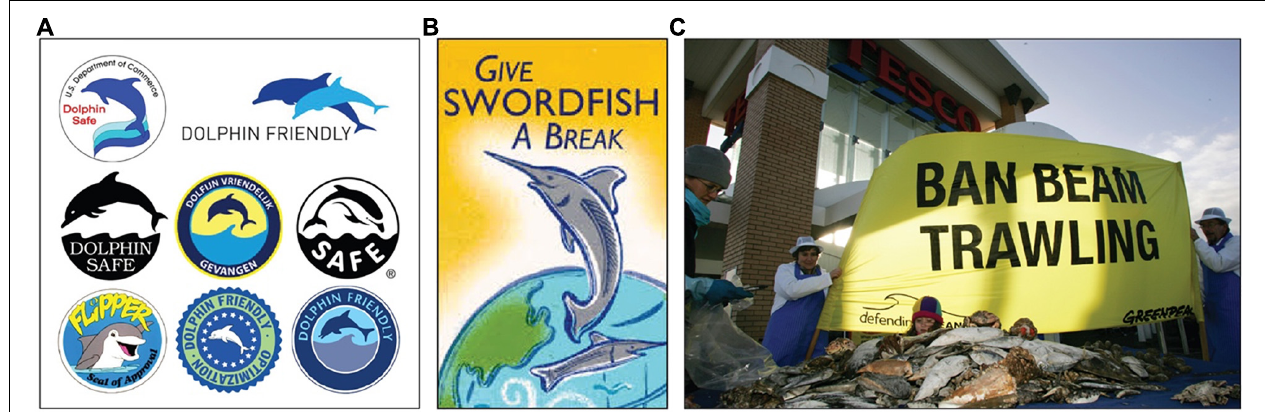
FIGURE 1 | Seafood boycott milestones. (A) Dolphin-safe tuna labels; (B) poster for “Give Swordfish a Break” campaign; (C) bycatch deposited outside a Tesco supermarket in the United Kingdom during Greenpeace’s “Recipe for Disaster” campaign (Photograph from John Cobb, reproduced with permission from Greenpeace image database